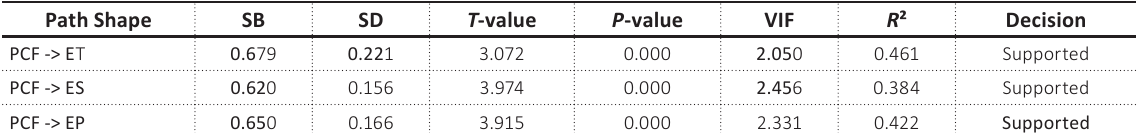
Table 4. Hypotheses testing